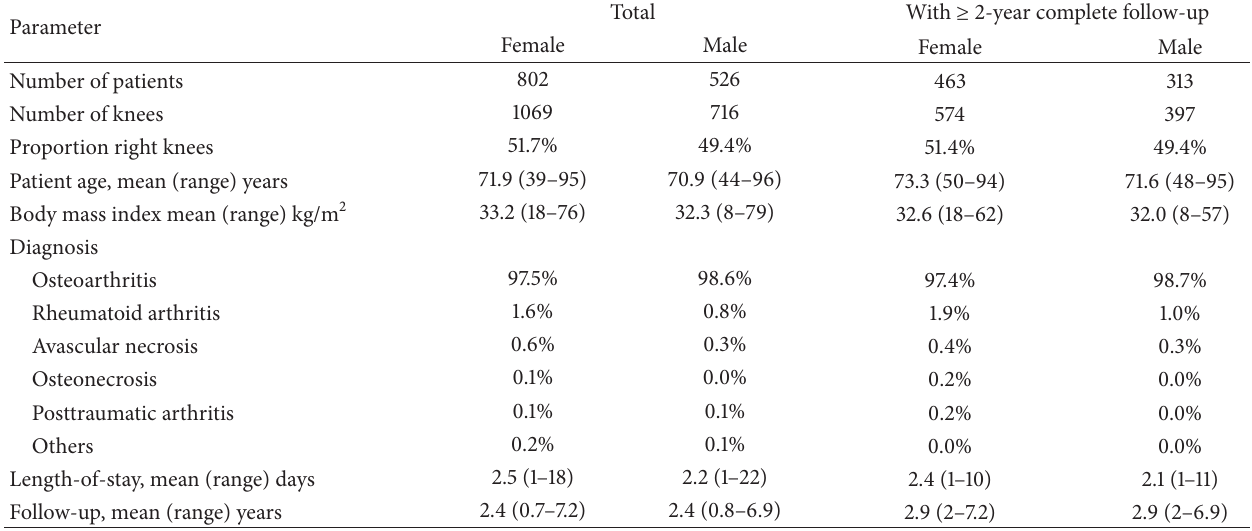
Table 1: Patient demographics.